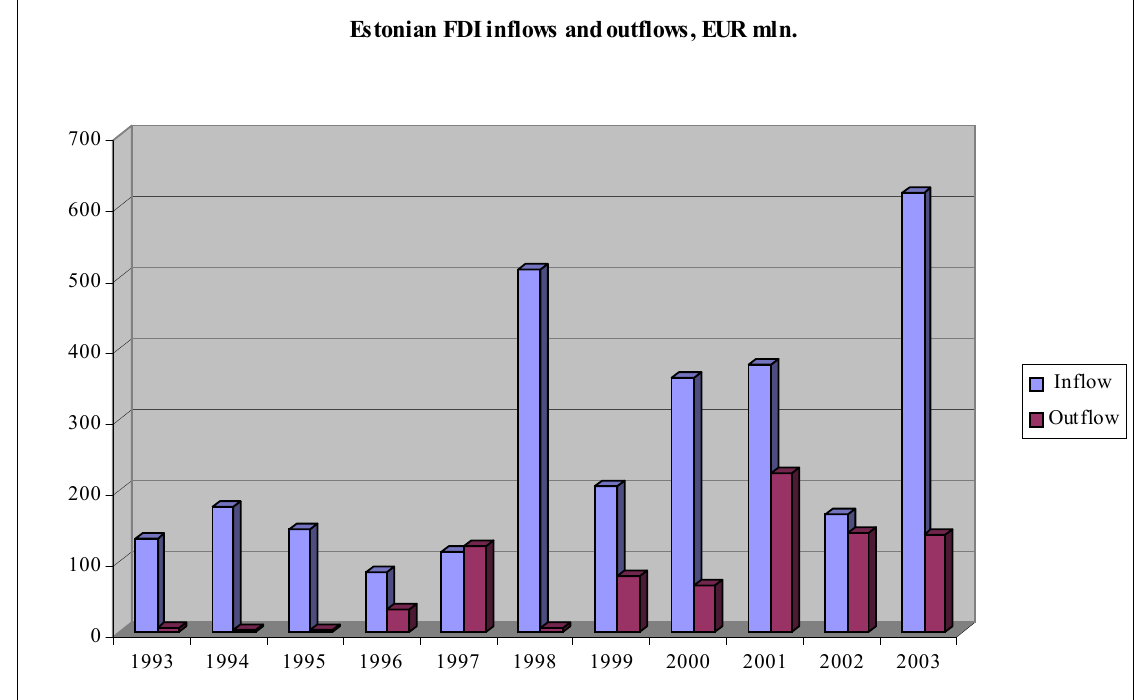
Figure 3. Estonian FDI inflows and outflows, 1993-2003 (Kivits K., Purju A., 2003)